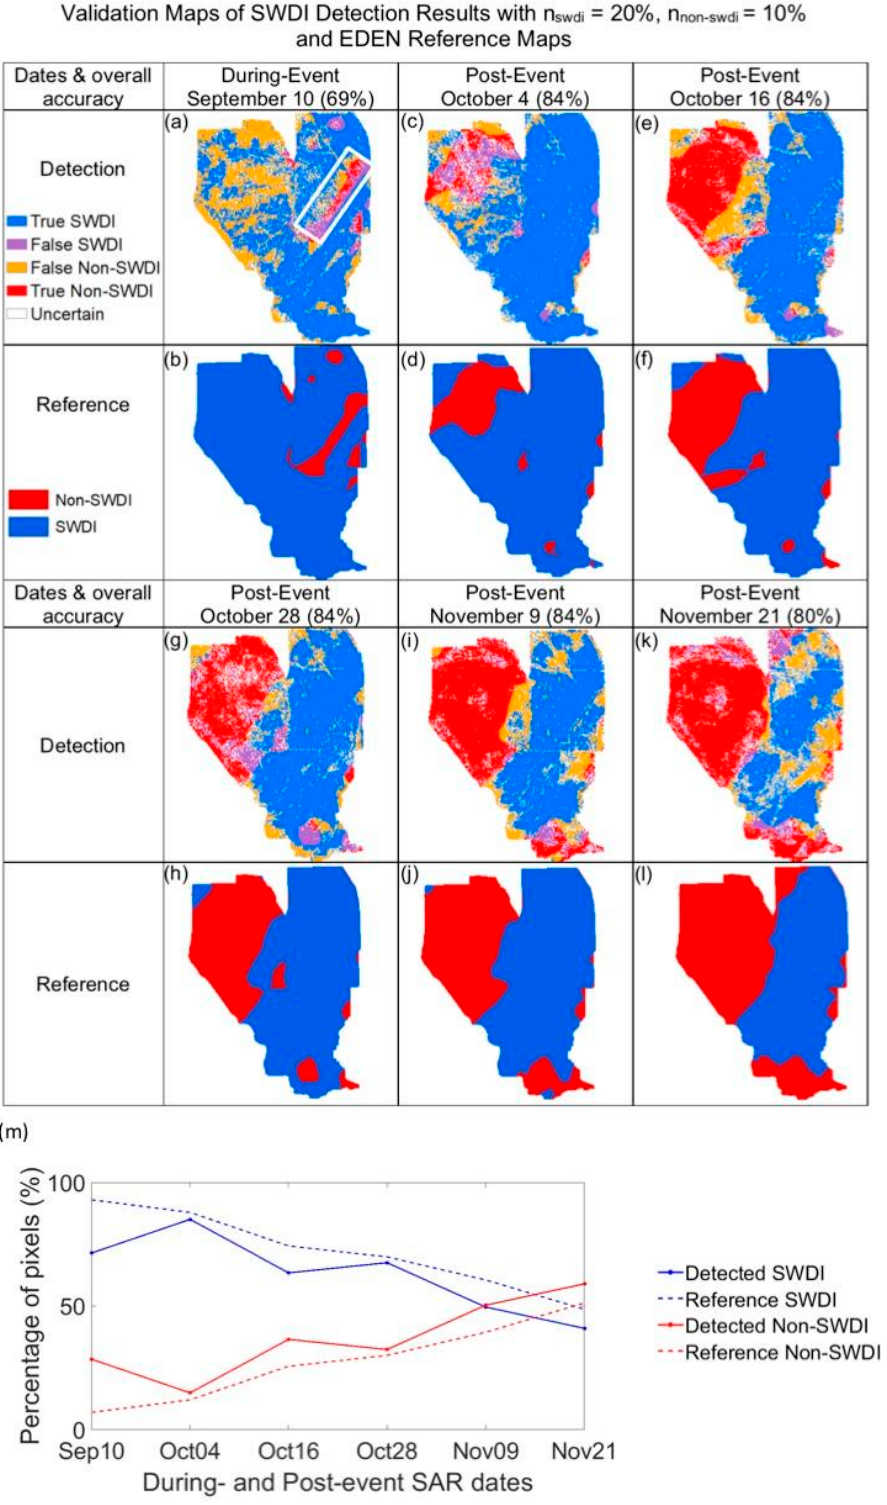
Figure 7. ( a – l ) Validation maps for SWDI detection and corresponding reference maps for the six target dates. The white polygon in ( a ) represents boundary areas between WCA-3A and 3B with a mix of true and false classifications. ( m ) Time series of pixel percentages of the classified and reference SWDI and non-SWDI classes.